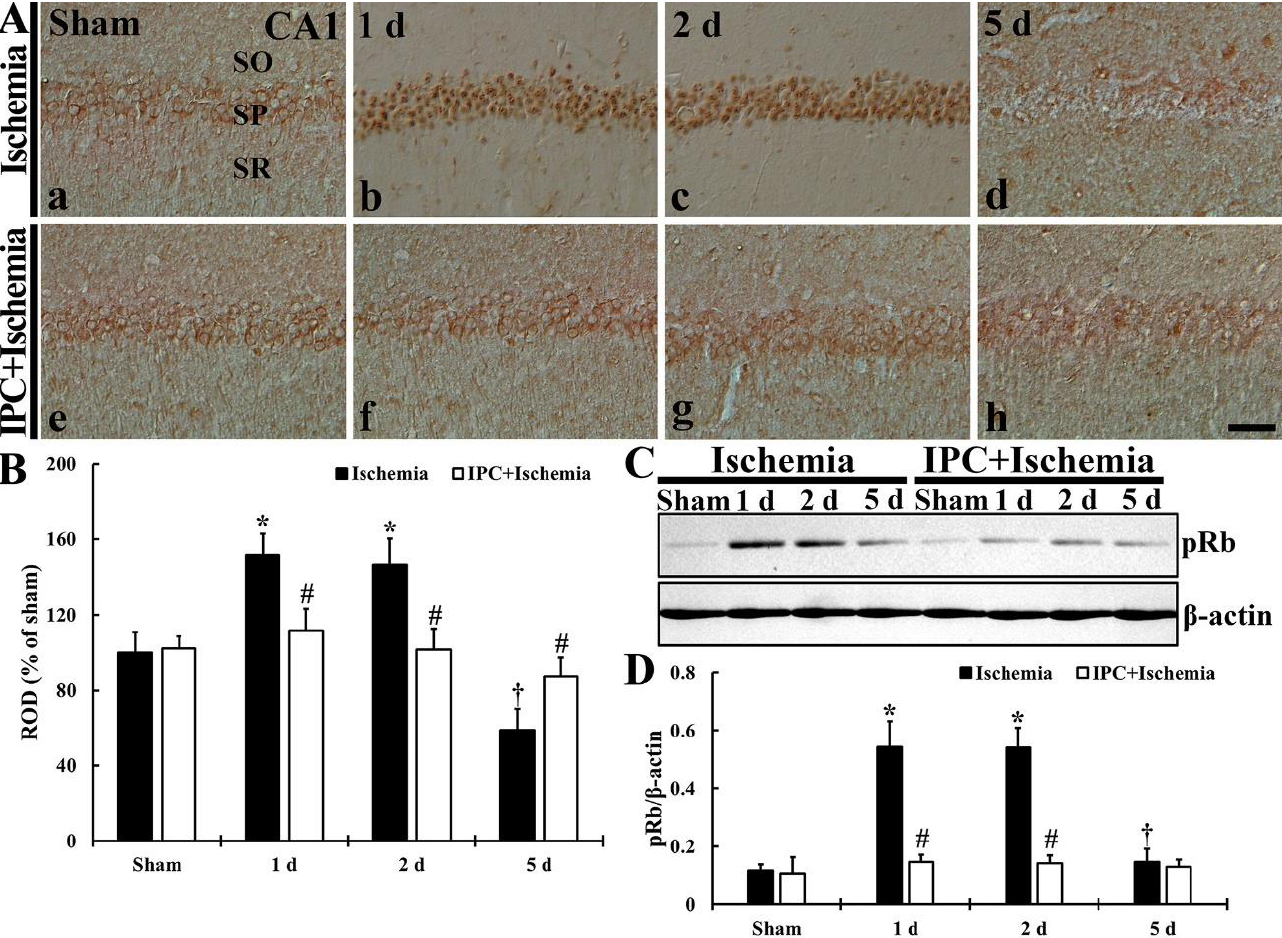
Figure 7. ( A ) Immunostaining of p -Rb in CA1 of the TI (upper column) and IPC+TI (lower column) groups at sham (a,e), 1 day (b,f), 2 days (c,g), and 5 days (d,h) after TI. p -Rb immunoreactivity is strongly detected in the pyramidal cells at 1 day and 2 days after TI, but very weak at 5 days after TI. However, in the IPC+sham and IPC+TI groups, p -Rb immunoreactivity in pyramidal neurons is similar to that shown in the sham group. Scale bar = 50 µ m. ( B ) ROD graph of p -Rb immunoreactivity in pyramidal cells. ROD was calibrated as percent (sham group, 100%). The bars represent means ± SD ( n = 7, * p < 0.05 versus sham; # p < 0.05 versus TI group; † p < 0.05 versus prior time point of each group). ( C ) Western blot of p -Rb (110 kDa) in CA1 of the TI and IPC+TI groups at sham, 1 day, 2 days and 5 days after TI. β -actin is used for a protein loading control. ( D ) Relative band intensity of p -Rb level in CA1. The bars represent means ± SD ( n = 7, * p < 0.05 versus sham; # p < 0.05 versus TI group; † p < 0.05 versus prior time point of each